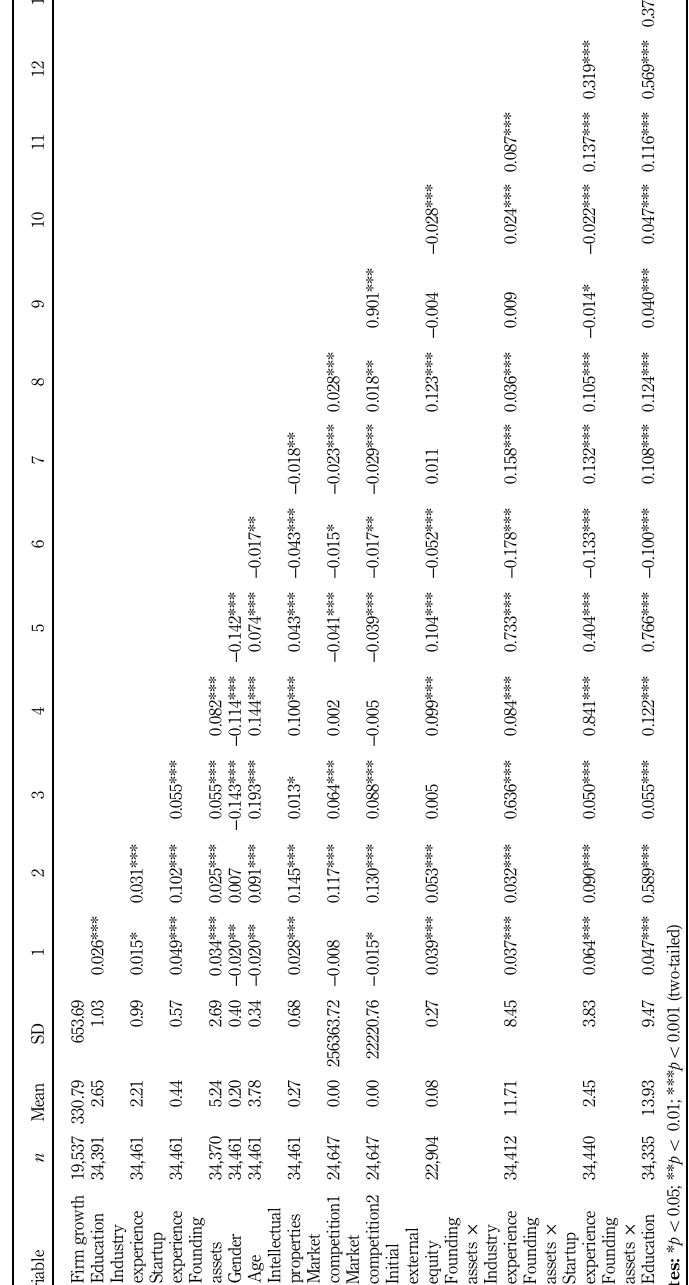
Table I. Descriptive statistics and correlation